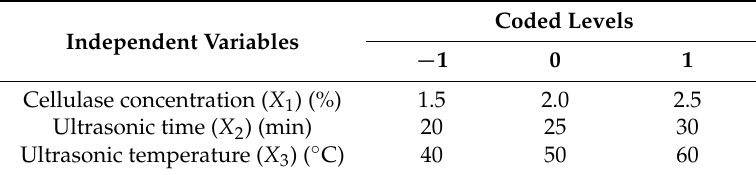
Table 4. Independent variables and their levels used for the Box-Behnken